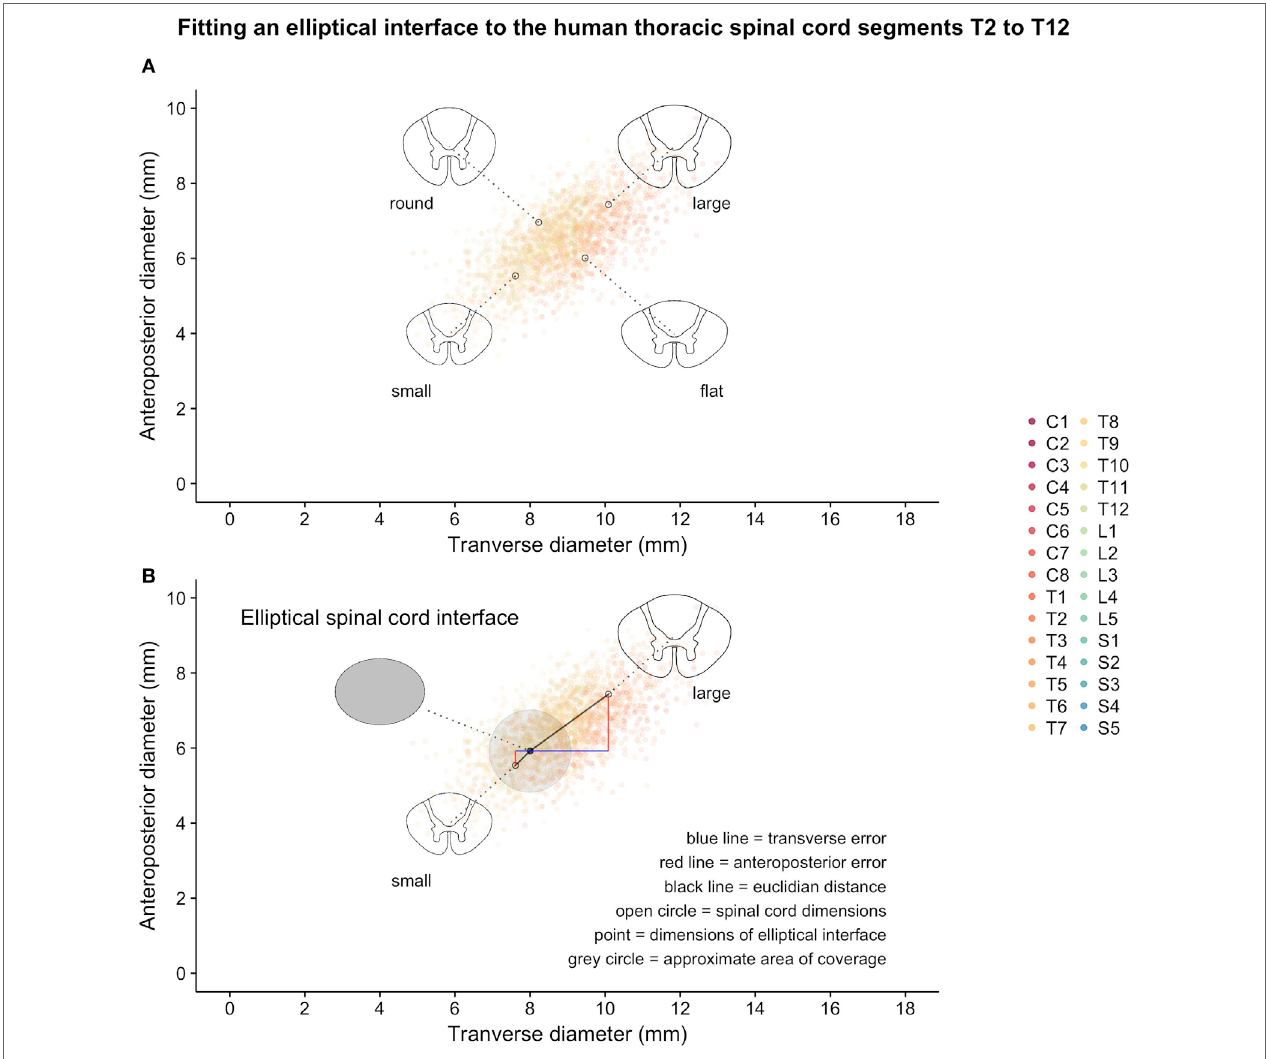
FigUre 2 | Thoracic segments T2–T12 from the same simulated data shown in Figure 1 : (a) examples of possible shapes and sizes of the thoracic spinal cord and (B) introduction of a hypothetical elliptical spinal cord interface and geometrical representations of various measures of error-of-fit as